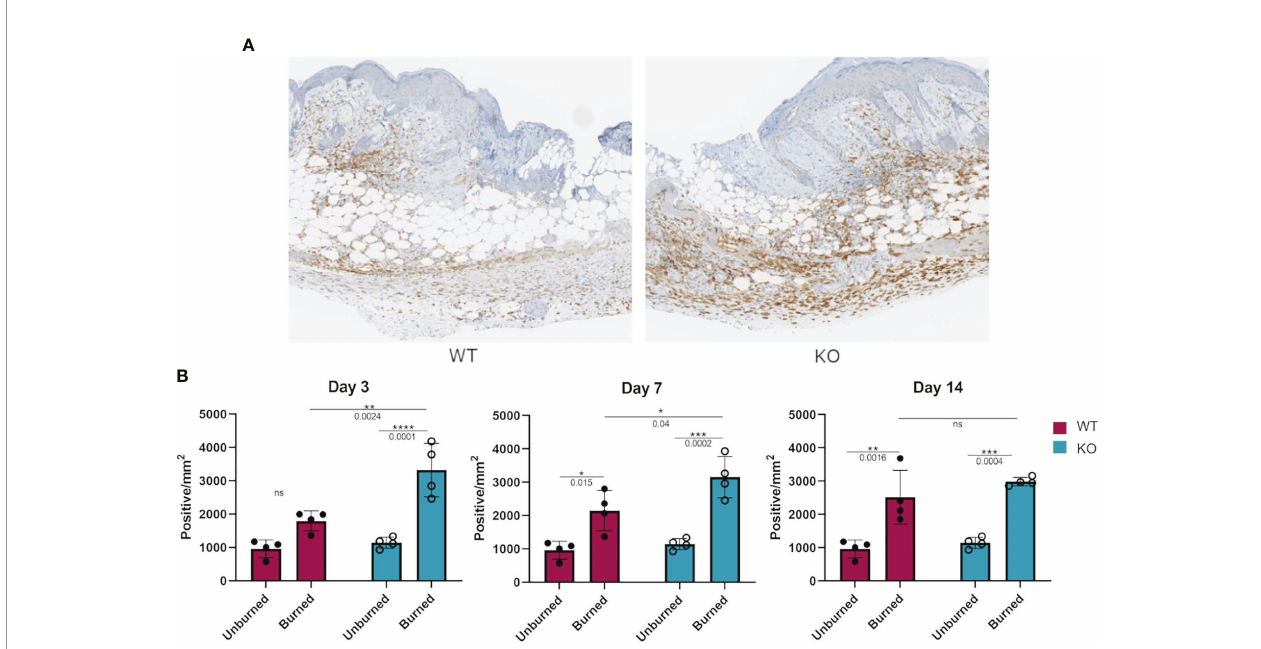
FIGURE 6 | Increased numbers of Iba1 + macrophages in burned skin of Dgka -/- mice. (A) IHC staining of Iba1 + macrophages from excised and bisected day 3 wounds of WT and Dgka -/- mice show increased number of cells at the site of the burn. (B) Quanti fi cation of Iba1 + stained cells in burned skin at three time-points in comparison to unburned skin. Each data point represents a single burn, with two burns per mouse per time-point for n = 6 mice per group. Error bars: SD. *p < 0.05, **p < 0.01, ***p < 0.001, ****p < 0.0001; ns, not signi fi cant; Two-way